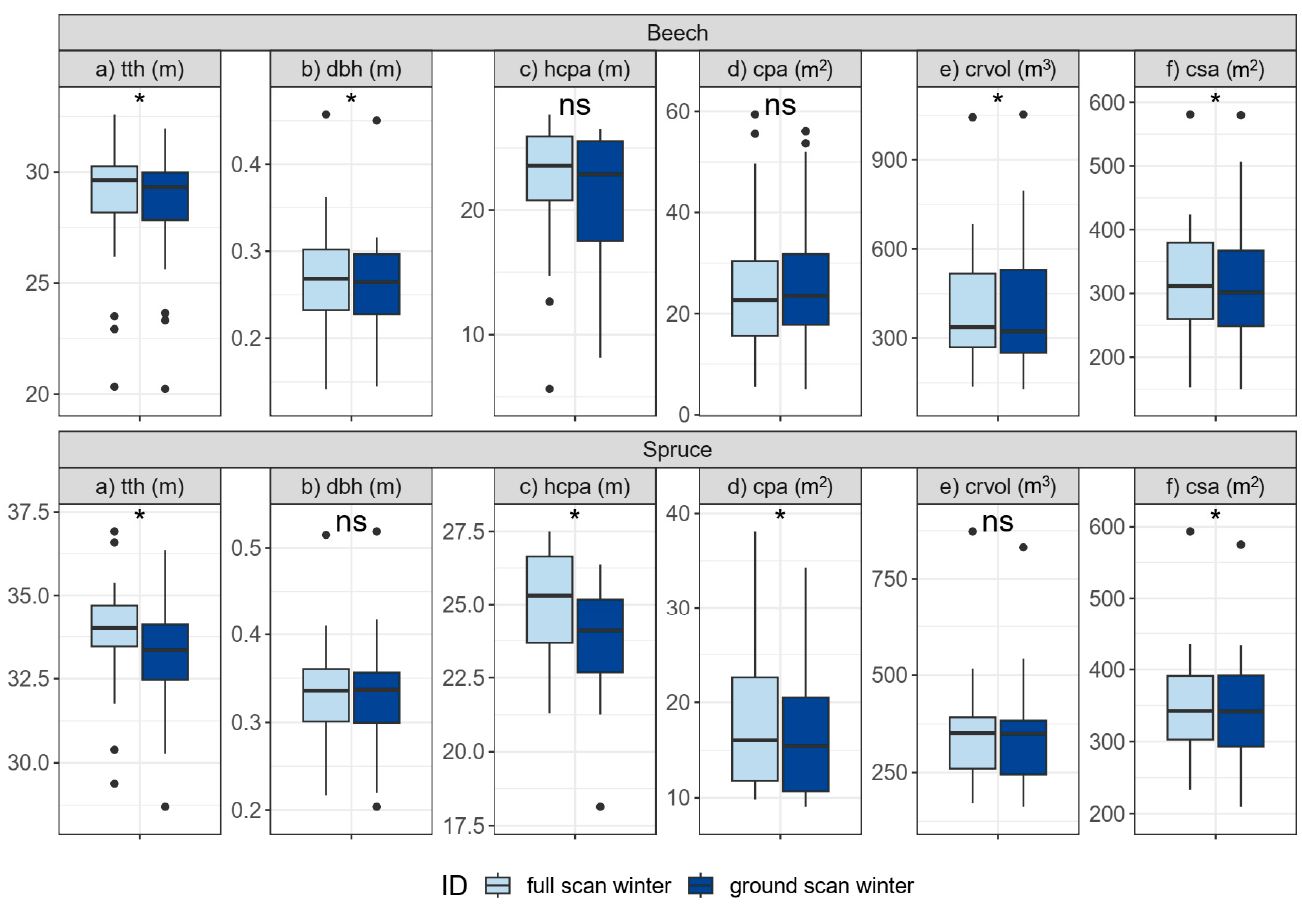
Figure 6. Methodological comparison between the ground scans and full scans conducted in winter of the single-tree morphologies of beech and spruce (n = 20 for each species). Shown are the total tree height (tth) ( a ), diameter at breast height (dbh) ( b ), height of maximum crown projection area (hcpa) ( c ), maximum crown projection area (cpa) ( d ), crown volume (crvol) ( e ) and crown surface area (csa) ( f ) for both winter scans. Asterisks indicate significant differences between the scans (*: p ≤ 0.05; ns: p > 0.05). Table 1. Mean difference ± standard deviation between the full scan in winter and the ground scan in winter for beech and spruce (n = 20 for each species). The data are presented in absolute (abs.) and relative values (rel. in %). Listed are the single-tree morphological variables total tree height (tth), diameter at breast height (dbh), height of maximum crown projection area (hcpa), maximum crown projection area (cpa), crown volume (crvol) and crown surface area (csa). The p-value indicates whether the difference is significant between beech and spruce.